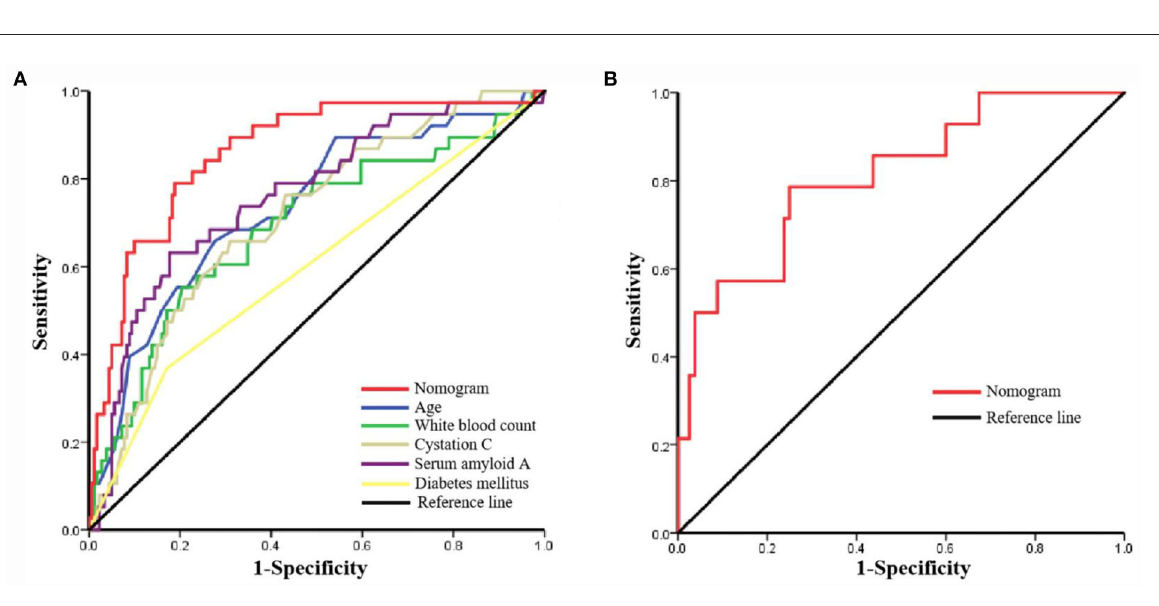
constructed a nomogram model based on SSA that can predict PSCI